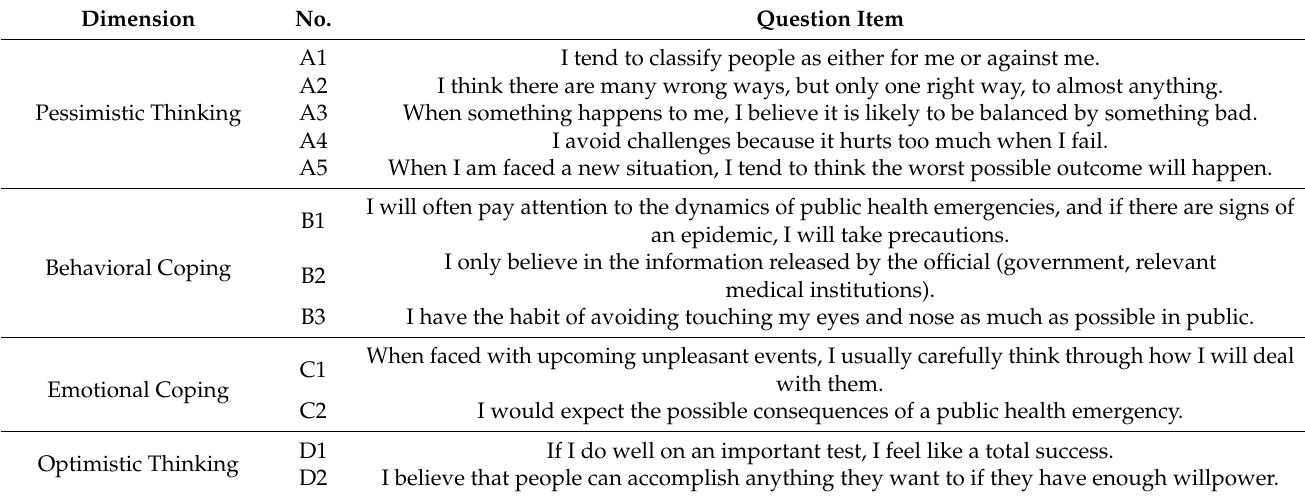
Table A3. Formal scale of public coping capacity to public health